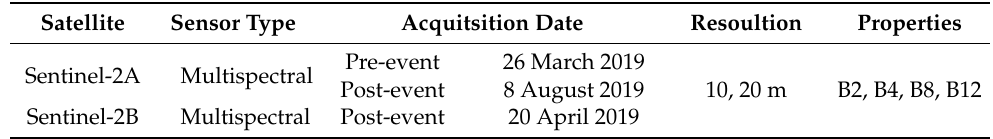
Table 1. Satellite